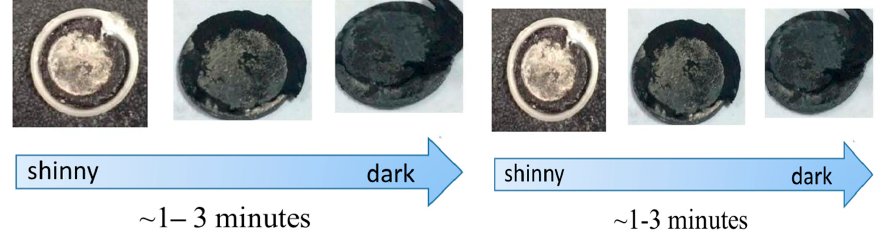
Figure 8. The picture of the surface belongs to the cell with an anode interlayer after 100 cycles at 0.1 C.